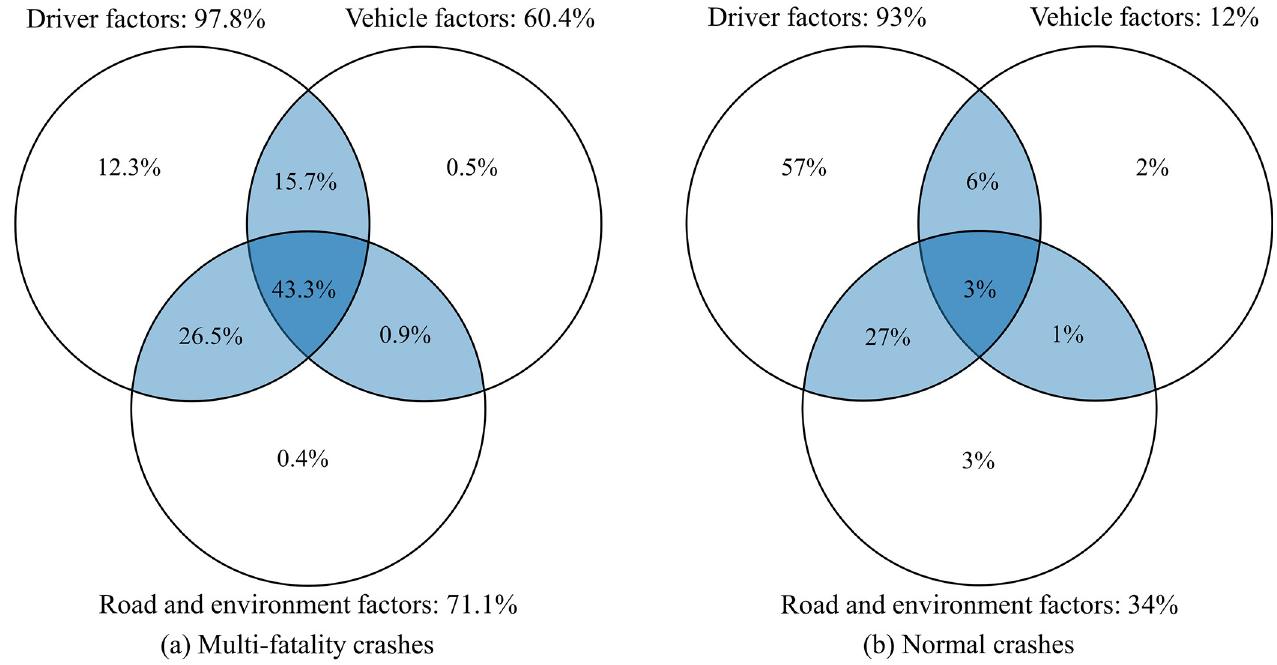
Fig 6. Contributing factors of multi-fatality crashes and normal crashes.